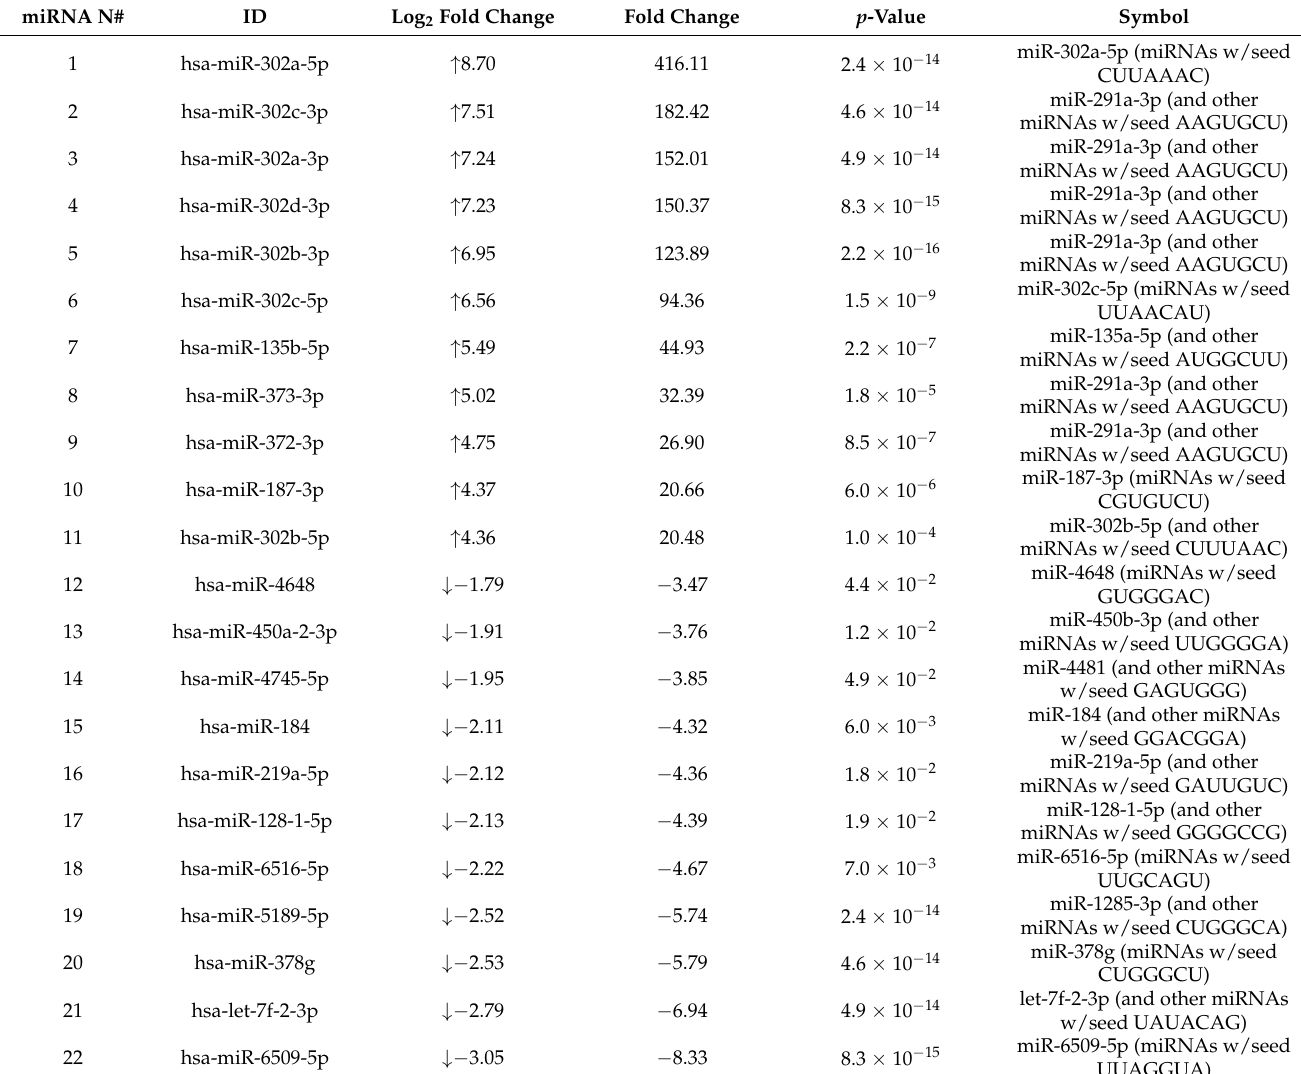
Table 7. The most differentially expressed miRNAs between individuals that expressed more symptoms (severe) and less symptoms (mild) (Absolute fold change > 2; p < 0.05).